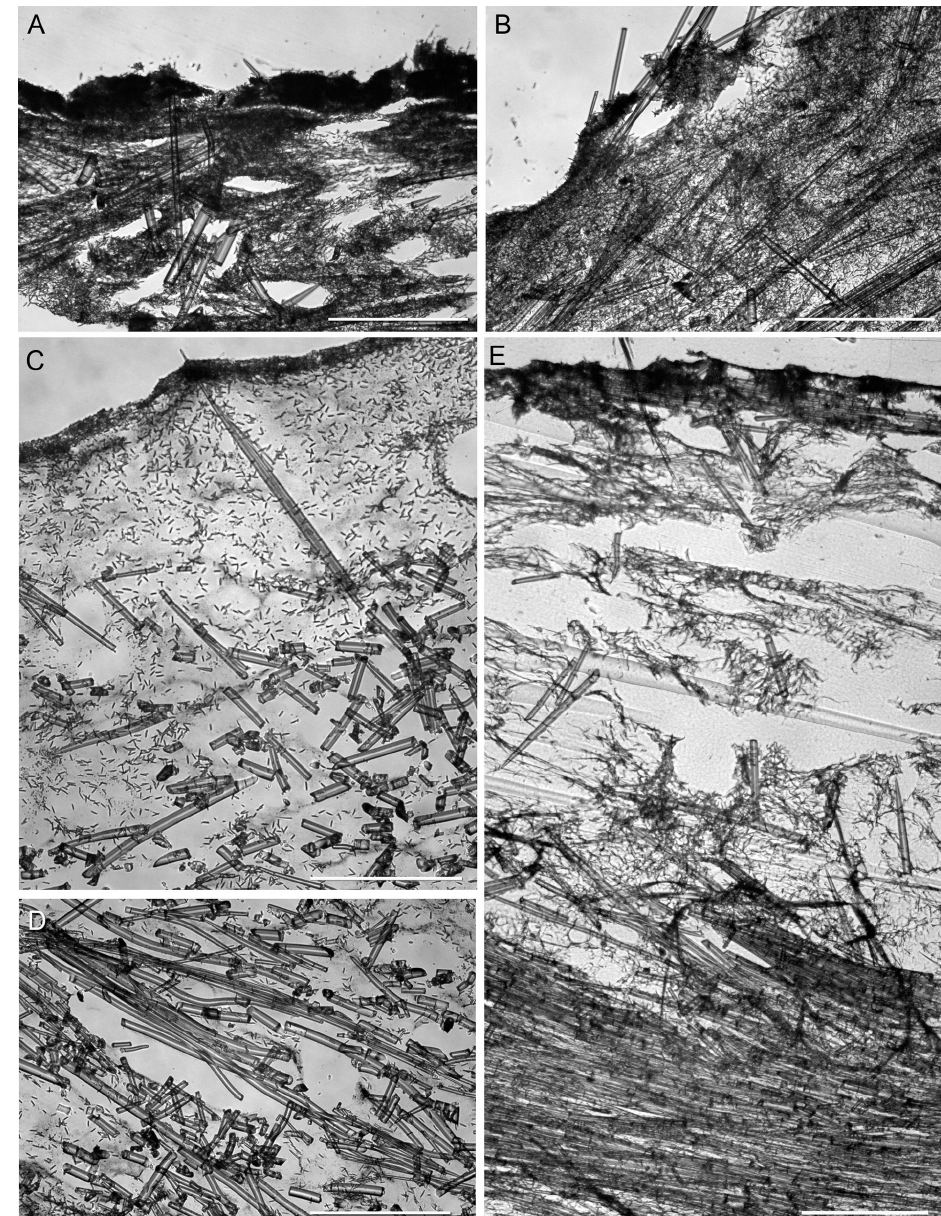
Fig. 6. Skeletal arrangement. A . Lamellomorpha australis Kelly & Cárdenas sp. nov. showing dense, crustose ectosome packed with microrhabds and other microscleres, a rough megasclere bundle in the subectosome, emerging perpendicular to the surface, and the choanosome densely packed with microscleres (NIWA 89736 leg., holotype). B . L. australis sp. nov. showing the subectosome densely packed with microscleres, and megascleres radiating in the plane of the sponge body (NIWA 89717 leg.). C . L. strongylata Bergquist, 1968 showing a thin, fleshy ectosome packed with microrhabds and other microscleres, through which projects an ‘extra-axial’ tract of megascleres, traversing the subectosome and projecting through the surface (NIWA 93474 leg.). D . L. strongylata showing the ‘axial’ arrangement of contort strongyloxeas in the deep choanosome (NIWA 93474 leg.). E . Poecillastra ducitriaenea Kelly & Cárdenas sp. nov. showing a densely packed, crustose ectosome through which subectosomal megascleres project, a relatively cavernous subectosomal region packed with microxeas, and in the deep choanosome, huge swathes of oxeas (NIWA 61944 leg., holotype). Scale bars = 500